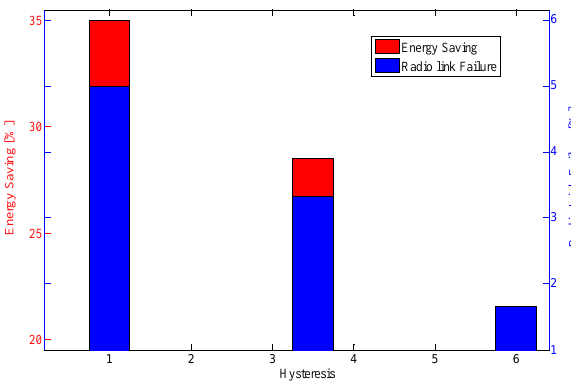
Figure 9. Mean of energy saving and RLF in REHO